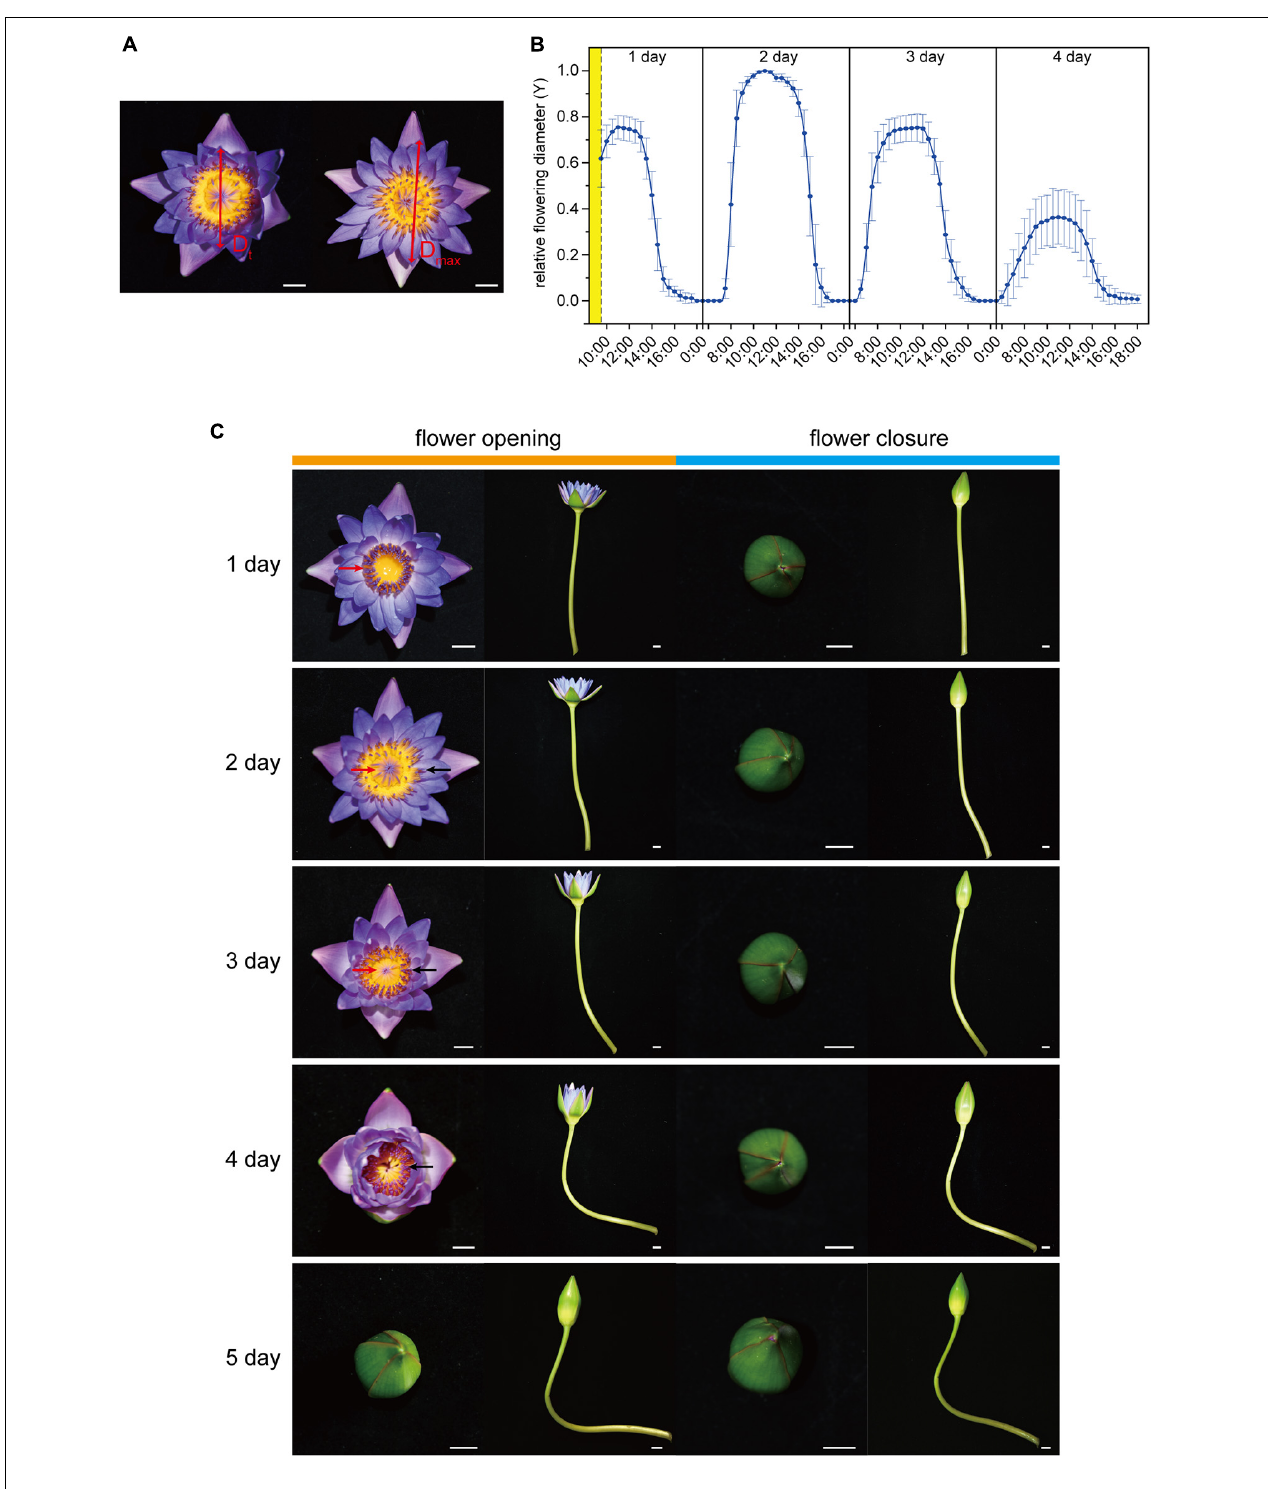
FIGURE 1 | Flower opening and closure process. (A) The flower opening and closing process was recorded based on the movement of a couple of petals in an opposite position. The measured diameter at time t (D t ) was normalized as Y = D t /D max , where D max represents the maximum of D t . (B) Flower opening and closure pattern in 1–4 days. The relative flowering diameter (Y) was measured and calculated every half hour. The cut flowers were harvested from 8:30 am to 9:30 am in the morning of the first blooming day (yellow part). As the flowers were closed from 17:30 pm to 6:30 am (Y = 0), data only at 17:30, 00:00, and 6:30 are shown, and the remaining data from this period have been omitted. (C) Opening and closing of waterlily flower over 1–5 days. The opening was captured at around 11:00 am, and the closure was captured at around 17:00 pm daily. The red arrows and black arrows mark the immature and mature stamens, respectively. Scale bar, 1 cm (A,C) .